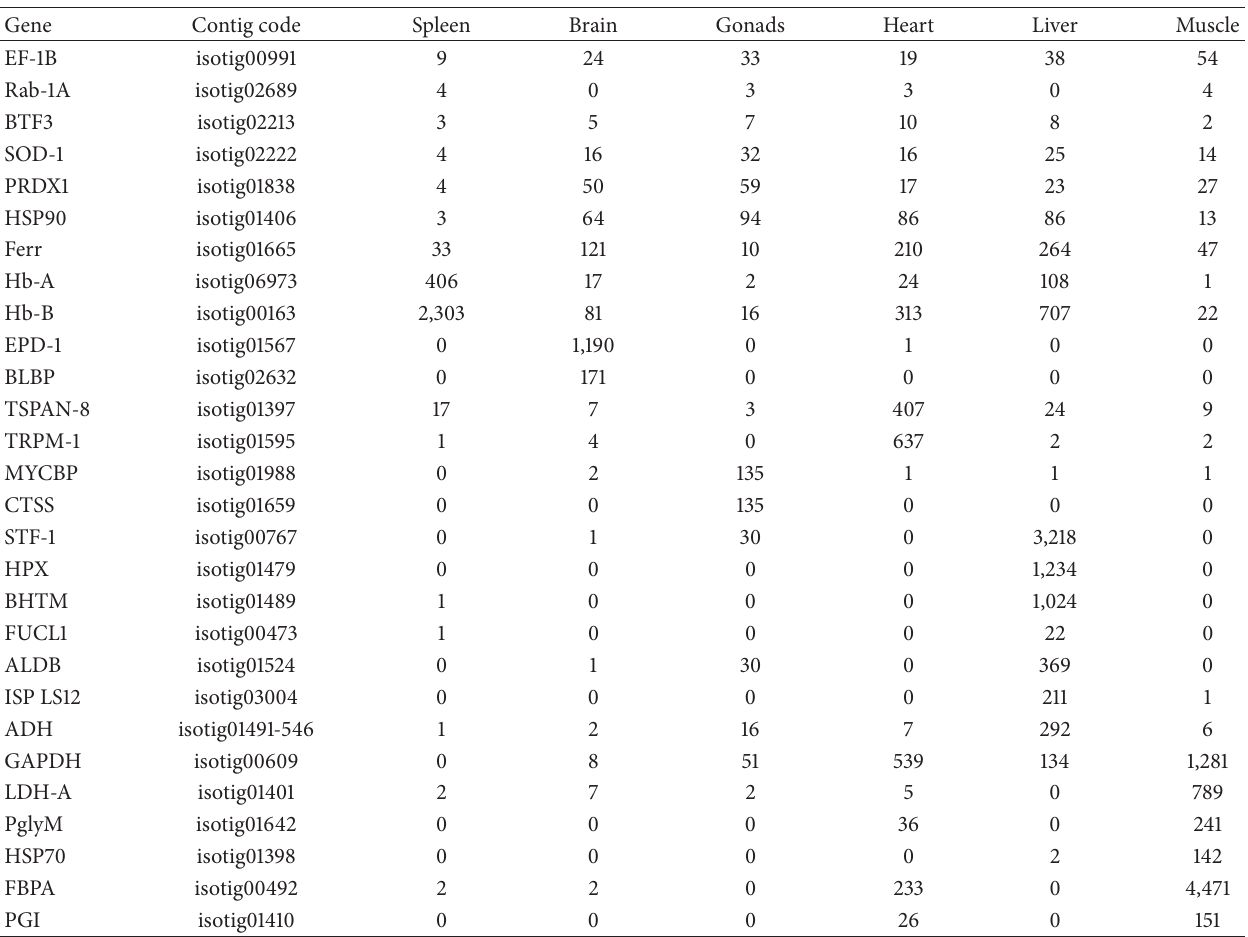
Table 5: Summary table of contig frequency for each of the tissues for those genes used to test the correlation with qPCR assays. S: spleen, B: brain, H: heart, G: gonad, L: liver and M: muscle. Names of genes based on their coding used in this table are found in